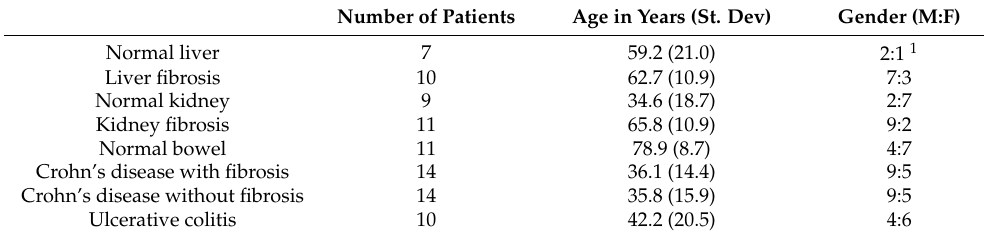
Table 2. Basic patients’ demographic data.